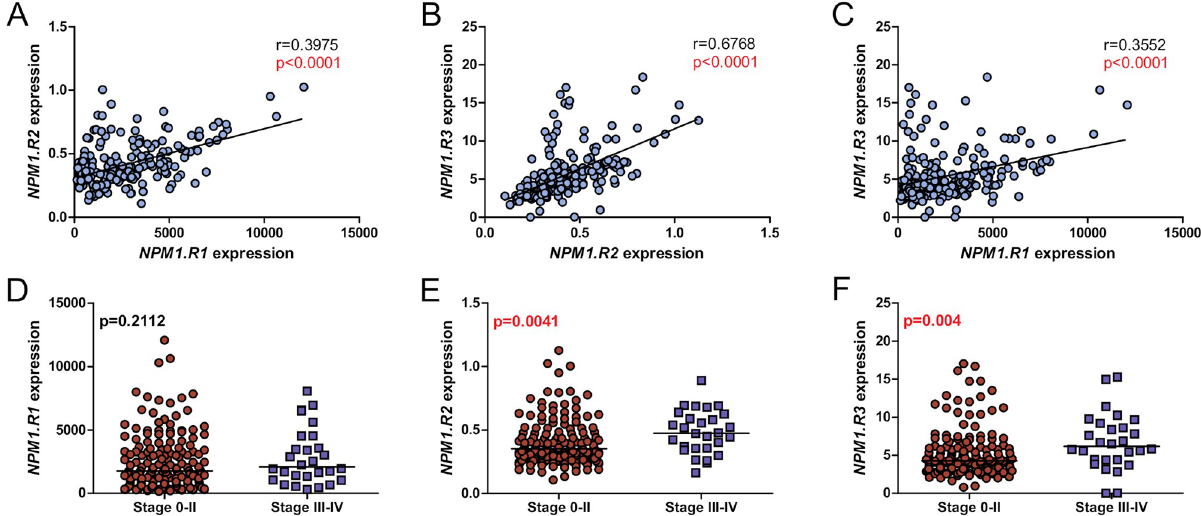
Fig 1. Expression levels of NPM1 splice variants in CLL patients. (A-C) Correlation between NPM1 . R1 , NPM1 . R2 , and NPM1 . R3 splice variants levels in CLL samples. Correlation plots include Spearman correlation coefficients. (D-F) The comparison of three NPM1 transcripts levels in CLL samples, according to Rai’s stage. Mann-Whitney P values are included. Each dot represents one sample. Statistically significant p values are indicated in